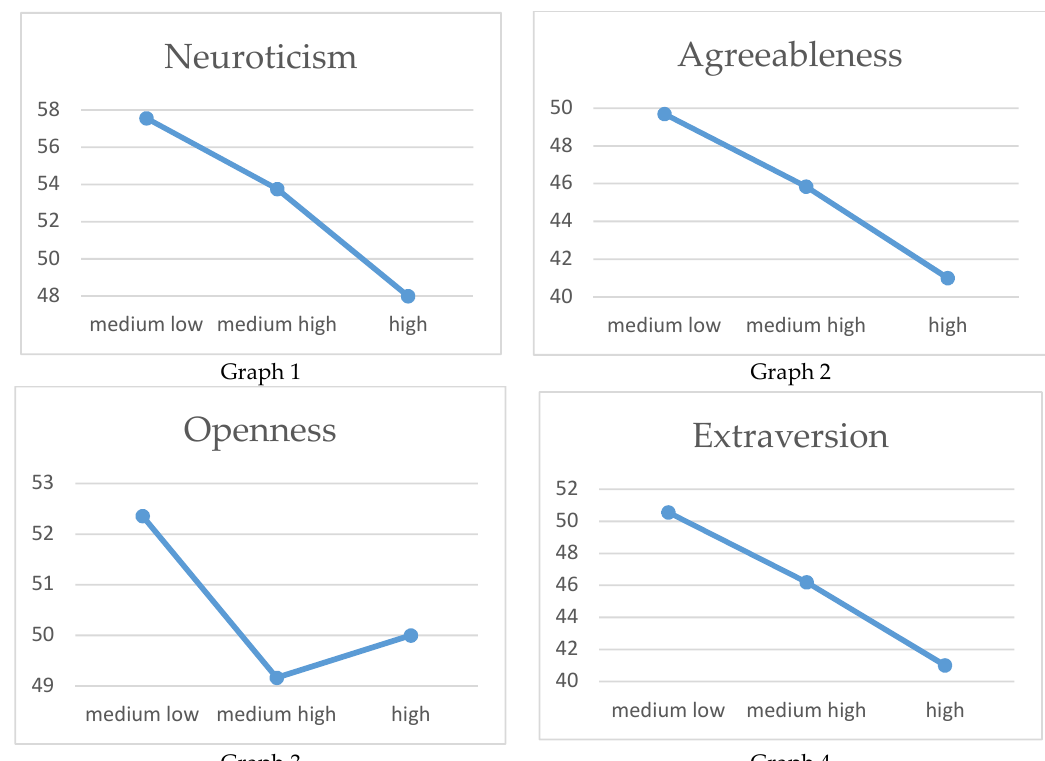
Figure 1. Graphical representation of the data averages in Table 2.